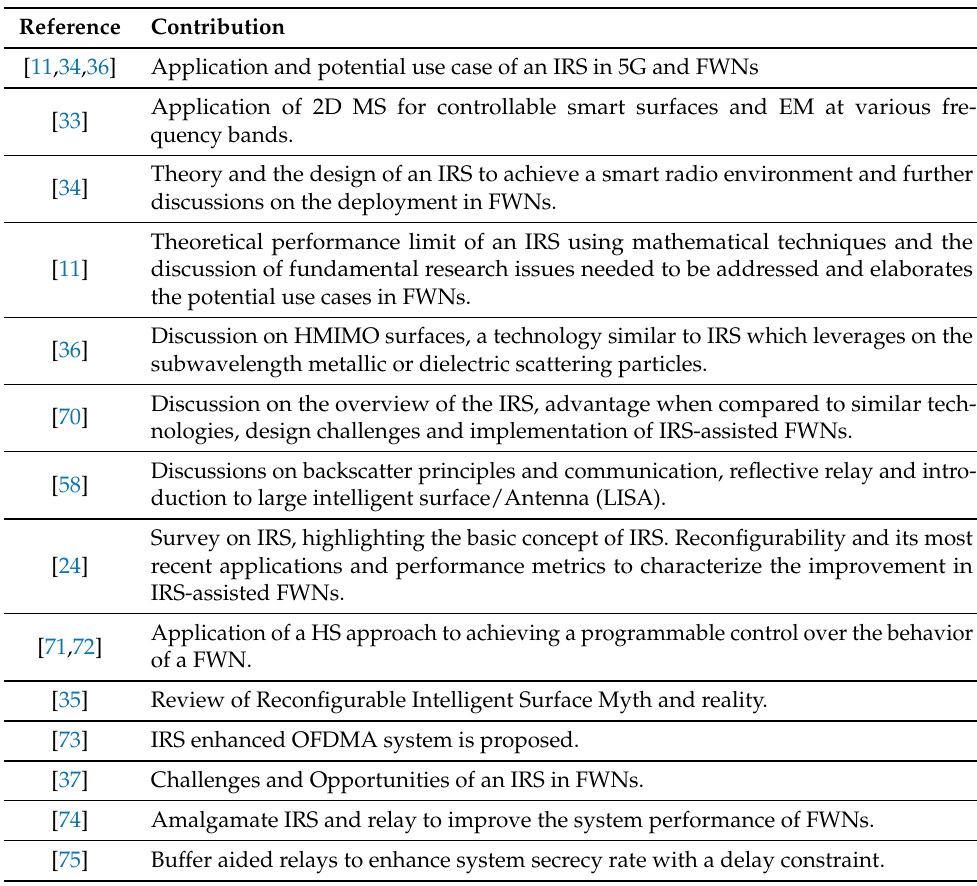
Table 2. Related Works on the Review on IRS